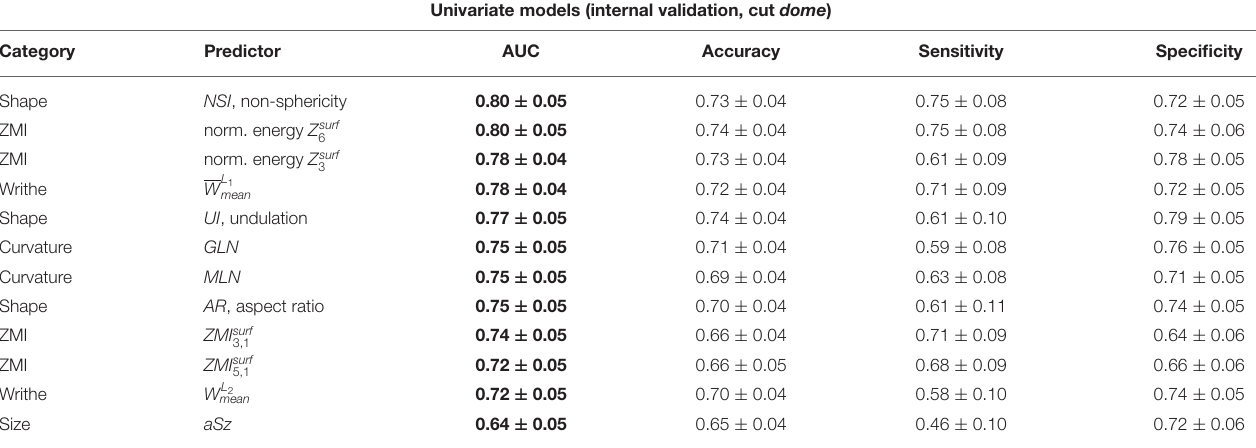
TABLE 5 | Internal validation results of the best univariate classification models, ordered by decreasing